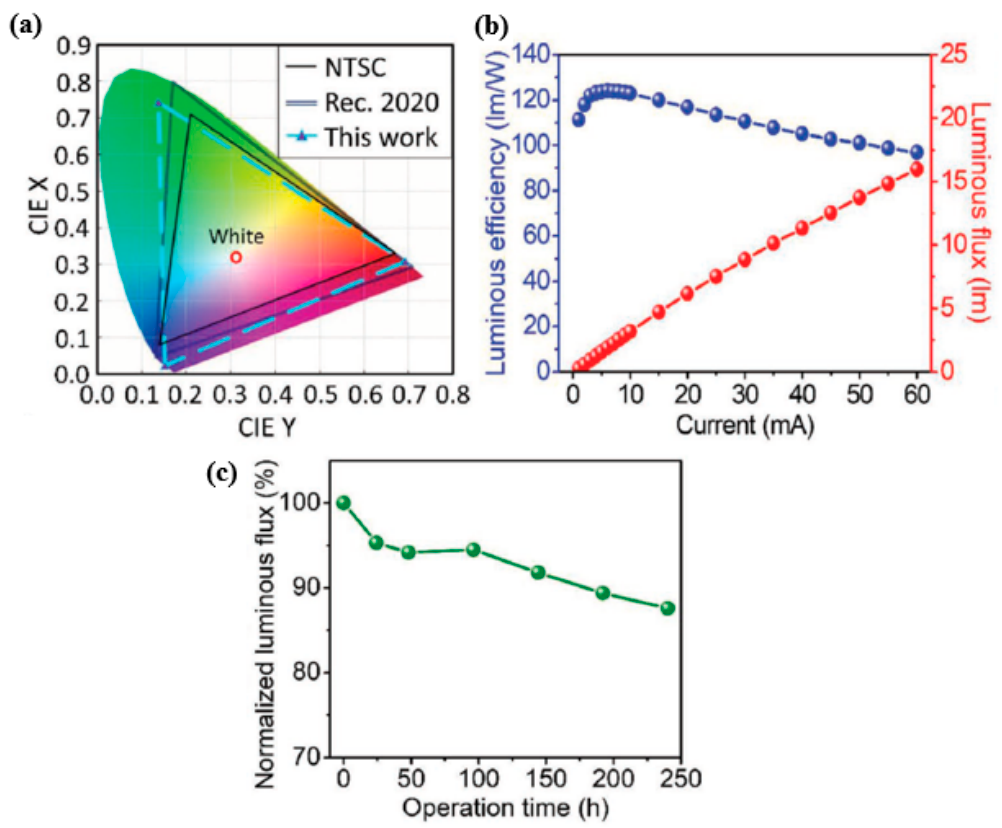
Figure 14. ( a ) CIE diagram illustrating the color gamut of the NTSC standard, the Rec. 2020 standard, and the PQD paper-based LED. ( b ) Current-dependent luminous efficiency and luminous flux of the PQD paper-based LED. ( c ) Time-dependent luminous flux of the LED device under continuous operation [78]. Figure reproduced with permission from John Wiley and Sons.